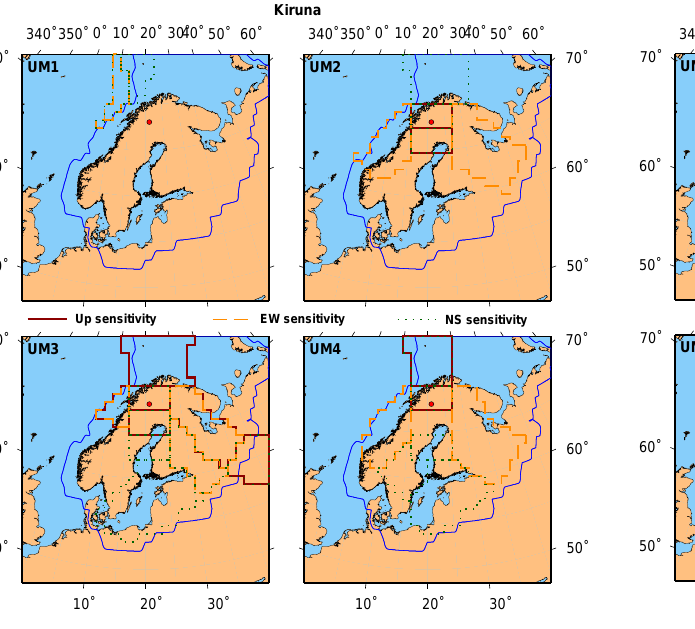
Figure 4. Location of viscosity blocks in each layer where sensitiv- Fig.5. SameasFig.4,butforSkellefte˚a. Figure 5. Same as Fig. 4, but for Fig.4. LocationofviscosityblocksineachlayerwheresensitivitykernelsofthevelocitiesinKiruna(reddot)lieaboveselectedthreshold. Redsolidline:verticalvelocity.Orangedashedline:EWvelocity.Greendottedline:NSvelocity.Blueline:formerglaciatedareabasedon ity kernels of the velocities in Kiruna (red dot) lie above the selected icemodelFBKS8.Depthranges:UM170–250km,UM2250–450km,UM3450–550km,UM4550–670km. threshold. Red solid line: vertical velocity. Orange dashed line: EW velocity. Green dotted line: NS velocity. Blue line: former glaciated area based on ice model FBKS8. Depth ranges: UM1 70–250km, UM2 250–450km, UM3 450–550km, UM4 550–670km.